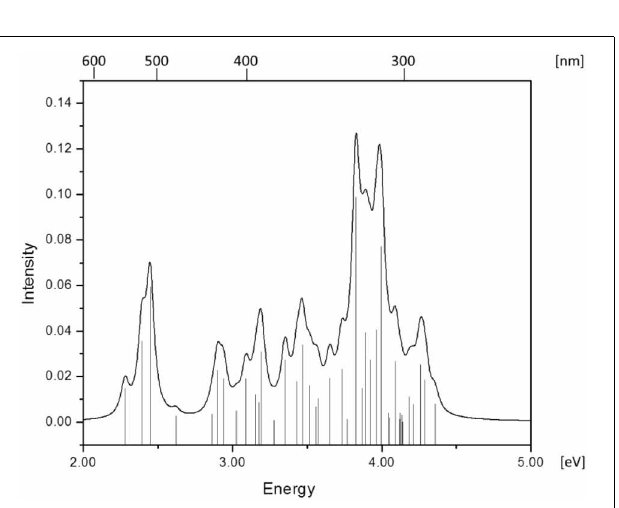
FIGURE 2 | Absorption spectrum of RibCbl calculated in gas phase with BP86/TZVP.